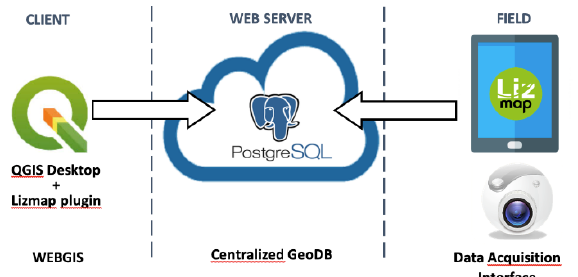
Figure 18. Spatial Information System